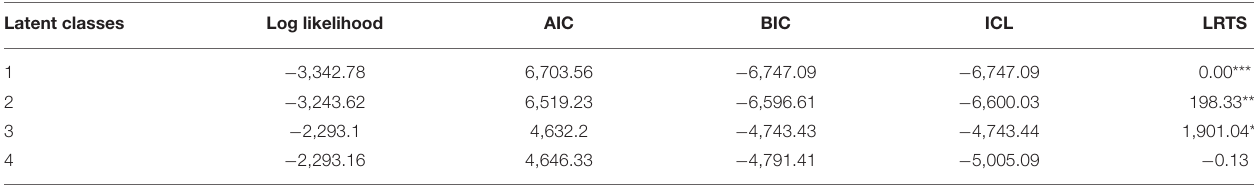
TABLE 7 | Comparison of number of latent classes according to latent profile analysis